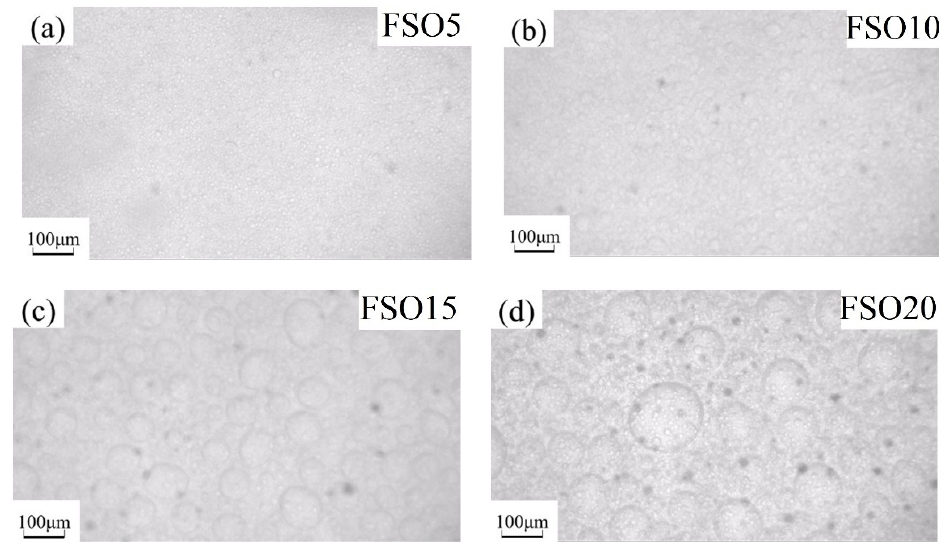
Figure 5. OM images of FSO/PDMS mixtures: ( a ) FSO5, ( b ) FSO10, ( c ) FSO15, ( d ) FSO20. Further quantitative analysis shows that the proportion of layered silicone oil in the total volume of the mixture increases linearly with the increase in the silicone oil concentration, as shown in Figure 6, and the limit proportion of the two types of PSO and FSO tends to be the same.